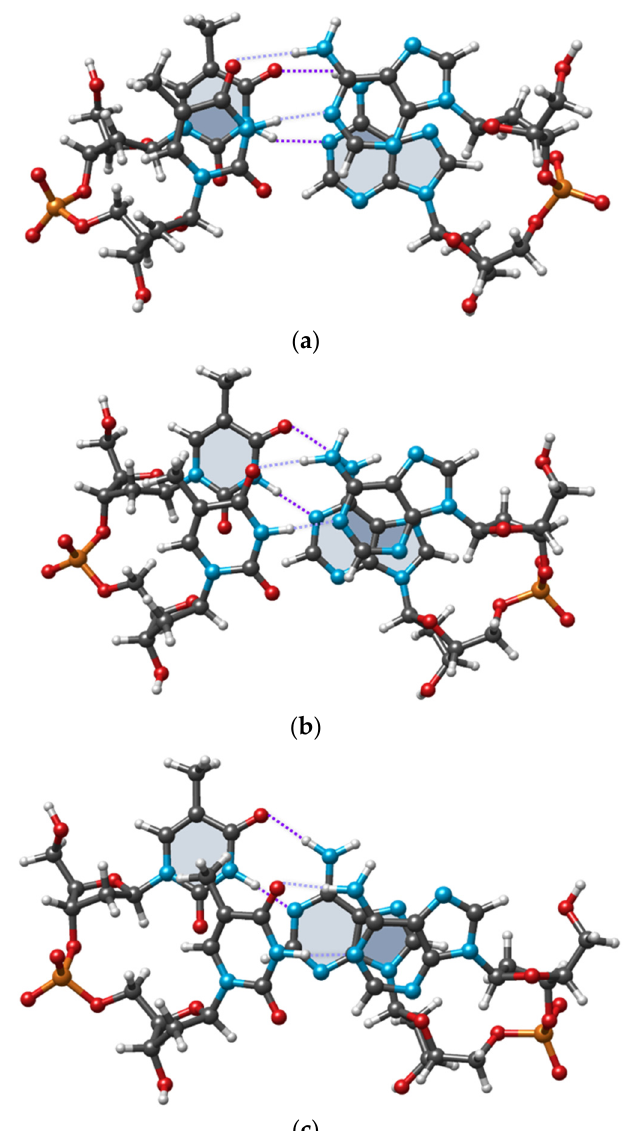
Figure 6. Experimental and optimized structures of dTpdT:dApdA with dTpdT (left chain) of BB02 NtC, and dApdA (right chain) of BB04 one. ( a ) Experimental structure (NDB ID PD0329); ( b ) Structure optimized by using M05-2X functional; ( c ) Structure optimized by using PBE functional.